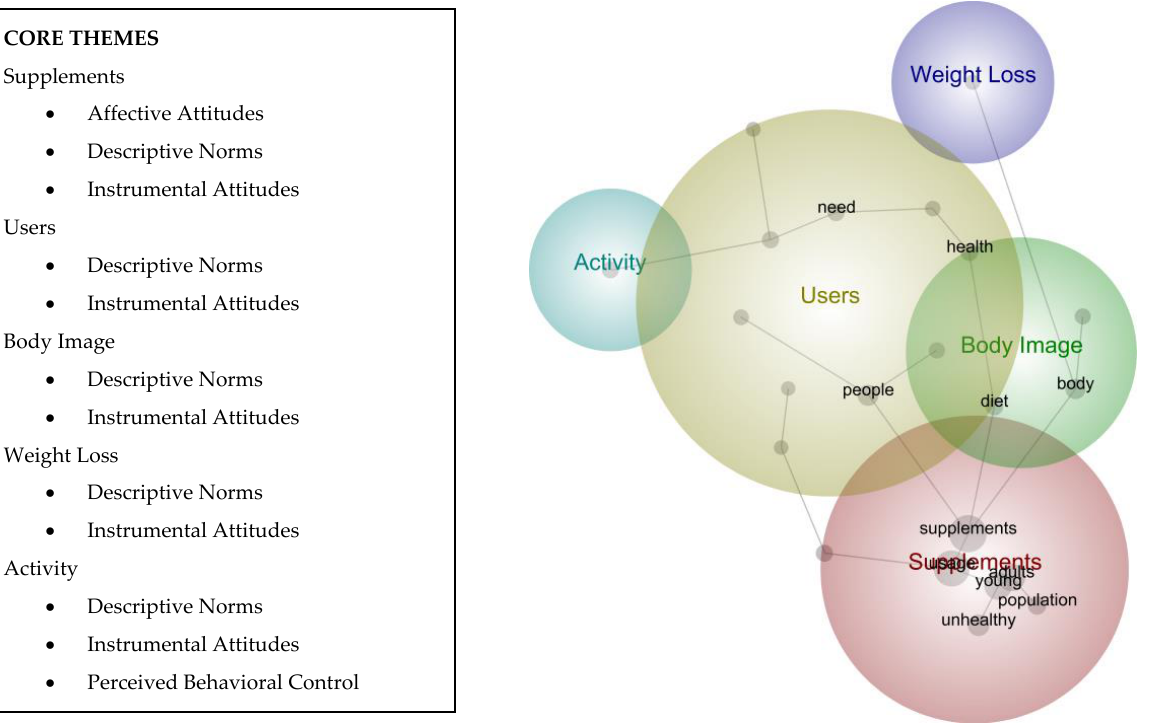
Figure 2. Leximancer theme map output.